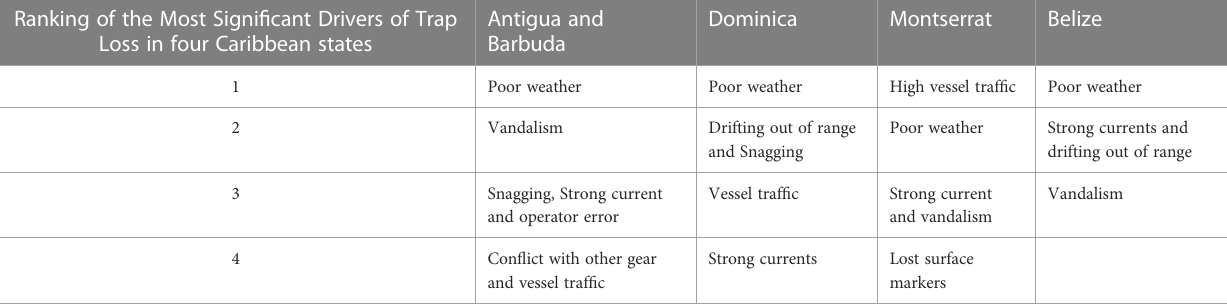
TABLE 1 Ranking of the most signi fi cant drivers of fi sh trap loss across four Caribbean states. Ranking of the Most Signi fi cant Drivers of